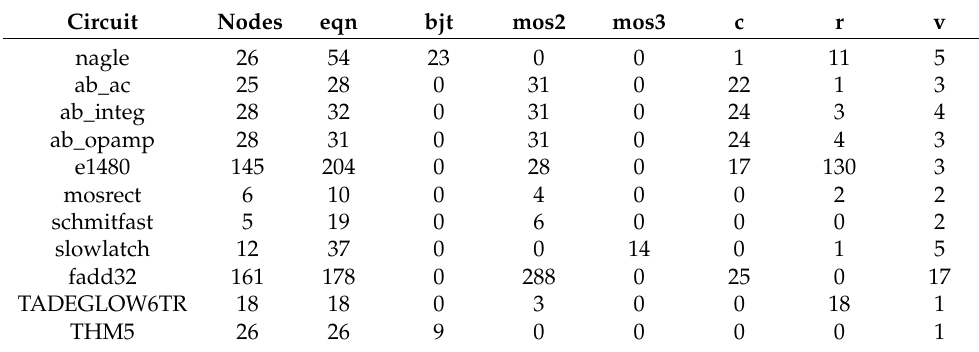
Table 4. Circuit characteristics with